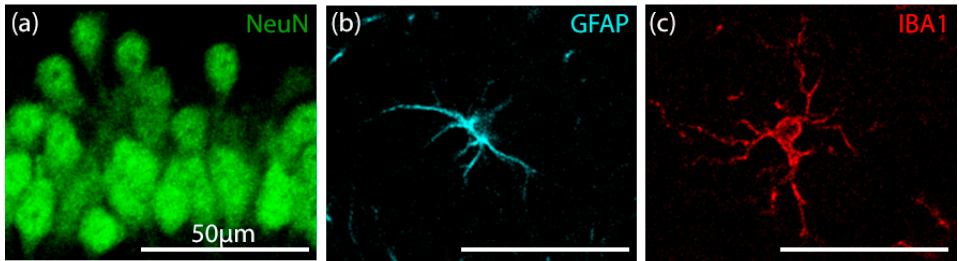
Figure 7. Neuron, astocyte, and microglia triade. Representative confocal microscopy image of the tripple immunostaining of the ( a ) neuron ‐ NeuN, ( b ) astrocyte ‐ GFAP, and ( c ) microglia ‐ IBA1 in the CA3 subfield of the hippocampus.